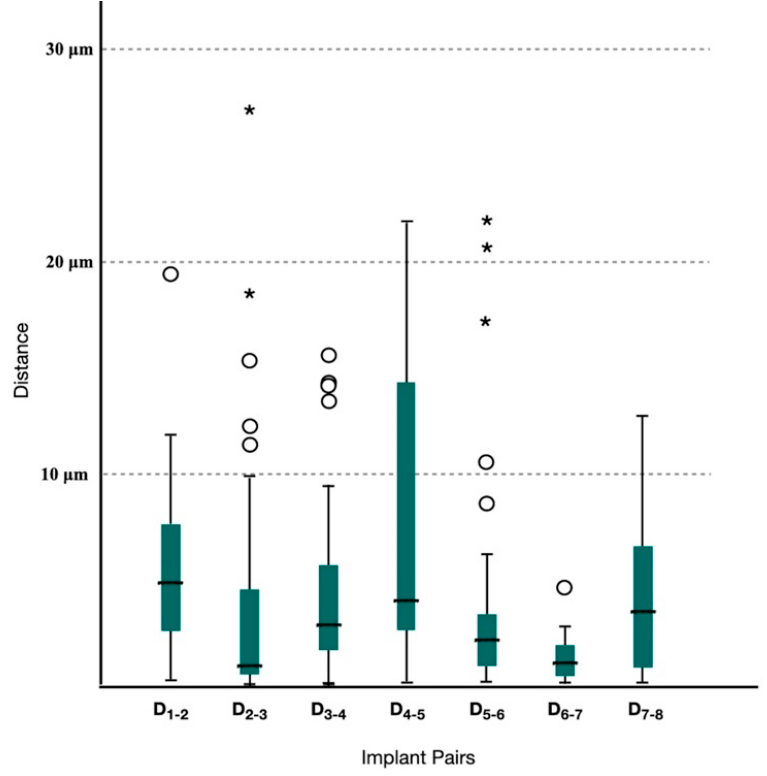
Figure 5. The distance deviations of implant pairs. * and ○ state outliers.